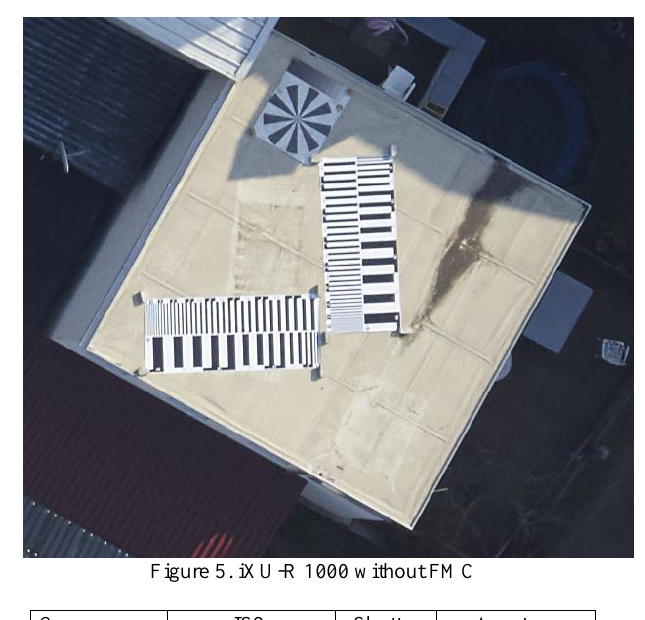
Figure 4. iXA 180 with FMC